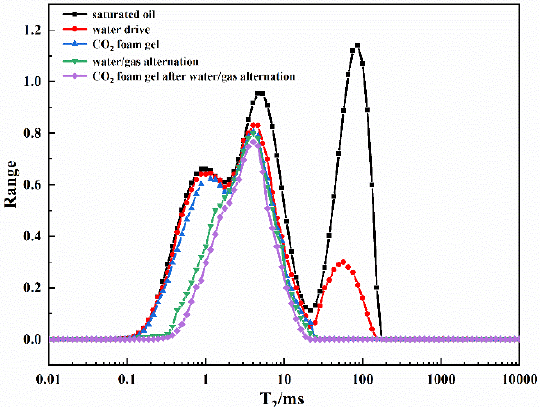
Figure 14. NMR T 2 spectra of different flow control systems in core No. 6.